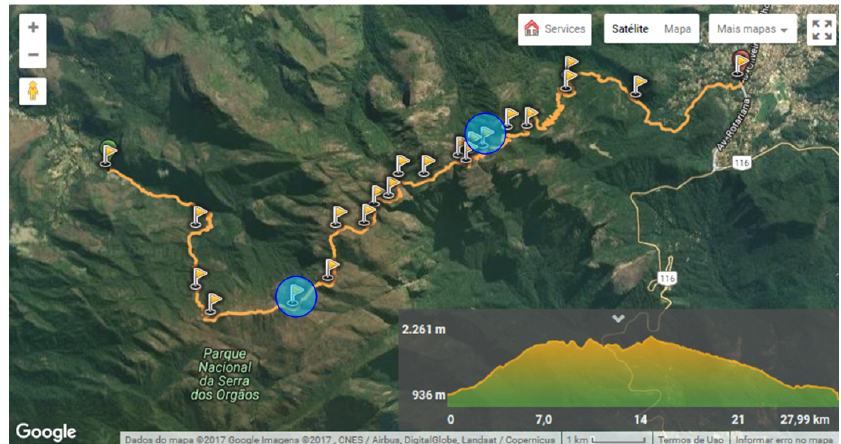
Figure 13. Route of Petrópolis—Teresópolis crossing.